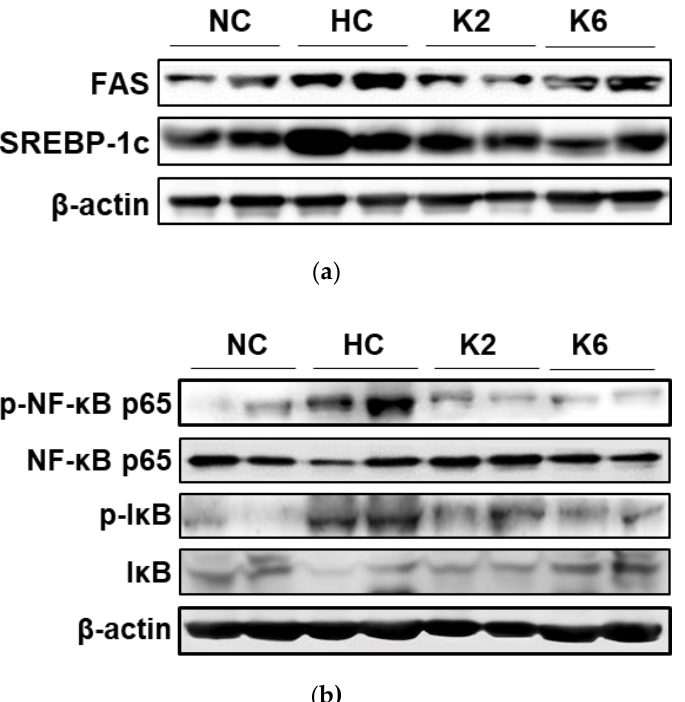
Figure 6. Effect of L. plantarum treatments on protein expression of lipogenesis and adipogenesis markers, and NF- κ B activation in the HFHF diet rat. Protein expression level of FAS, SREBP-1c, and PPAR γ ( a ) and phosphorylation level of NF- κ B and I κ B ( b ) in the small intestine. Images are representative of at least 3 independent experiments (for each group n = 2). NC, normal diet control; HC, HFHF diet control; K2, HFHF diet with K2; K6, HFHF diet with K6; FAS, fatty acid synthase; SREBP-1c, sterol regulatory element-binding protein 1c; p-NF- κ B p65, phospho-nuclear factor-kappa B p65; NF- κ B p65, nuclear factor-kappa B p65; p-I κ B, phospho-inhibitors of kappa B; I κ B, inhibitors of kappa